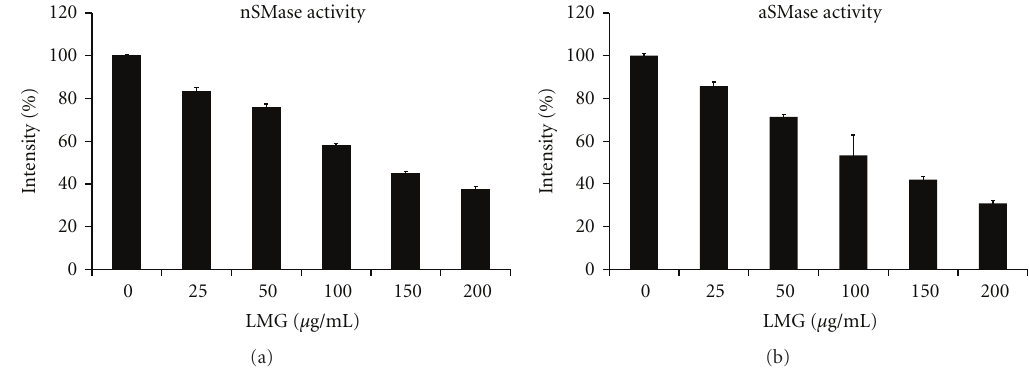
Figure 7: Amplex red assay evaluated LMG’s SMase inhibitory activity. The relative activities of nSMase (a) and aSMase (b) were detected after treatment with 0, 25, 50, 100, and 200 μ g/mL of LMG for 30min. The relative activity is presented as the means ± SD for n = 3 replicates.